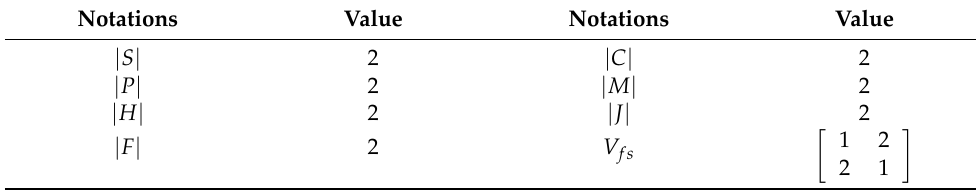
Table 1. The set of small designed